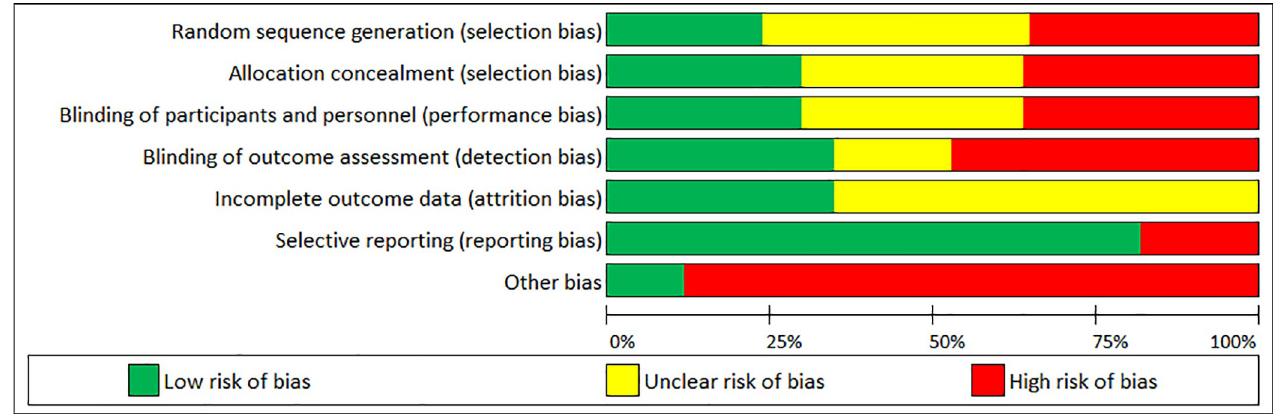
Fig 2. Risk of bias assessment. Results of the risk of bias assessment reported in S1 Table are summarized based on the Cochrane Collaboration tool.